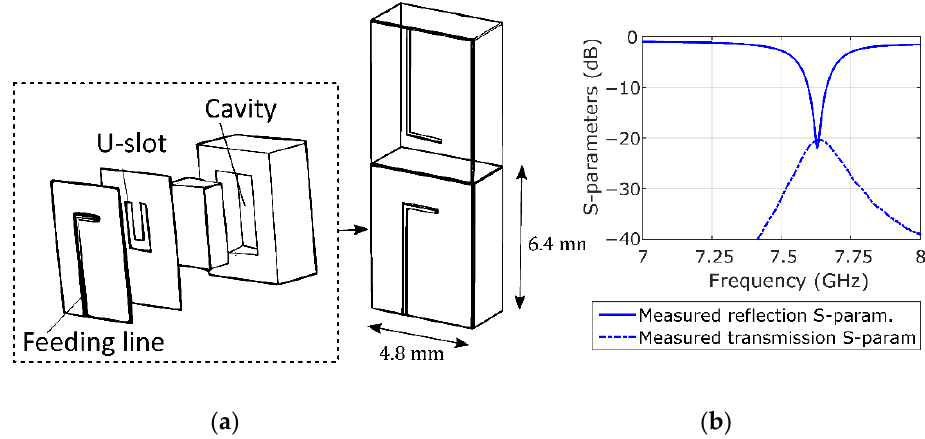
Figure 2. ( a ) Schematic of the cavity-backed slot antenna and a transmitting and receiving antenna pair. ( b ) Measured transmission and reflection S-parameters.